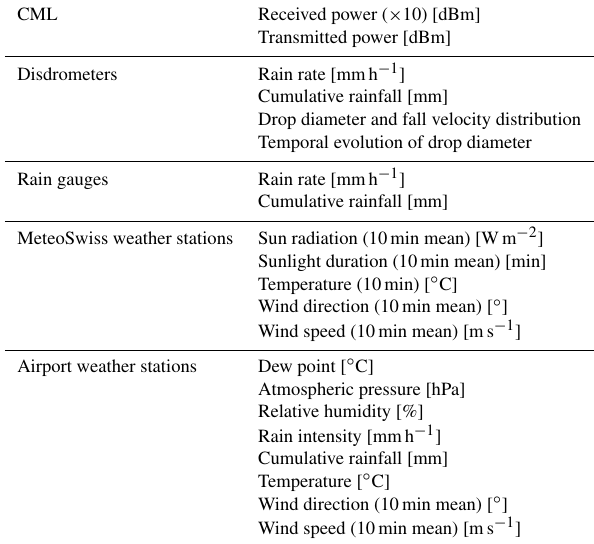
Table 4. Summary of quantities and their units displayed as daily plots in the html